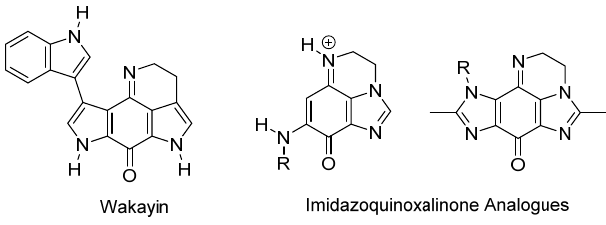
Figure 2. Imidazole-based wakayin analogues [10].